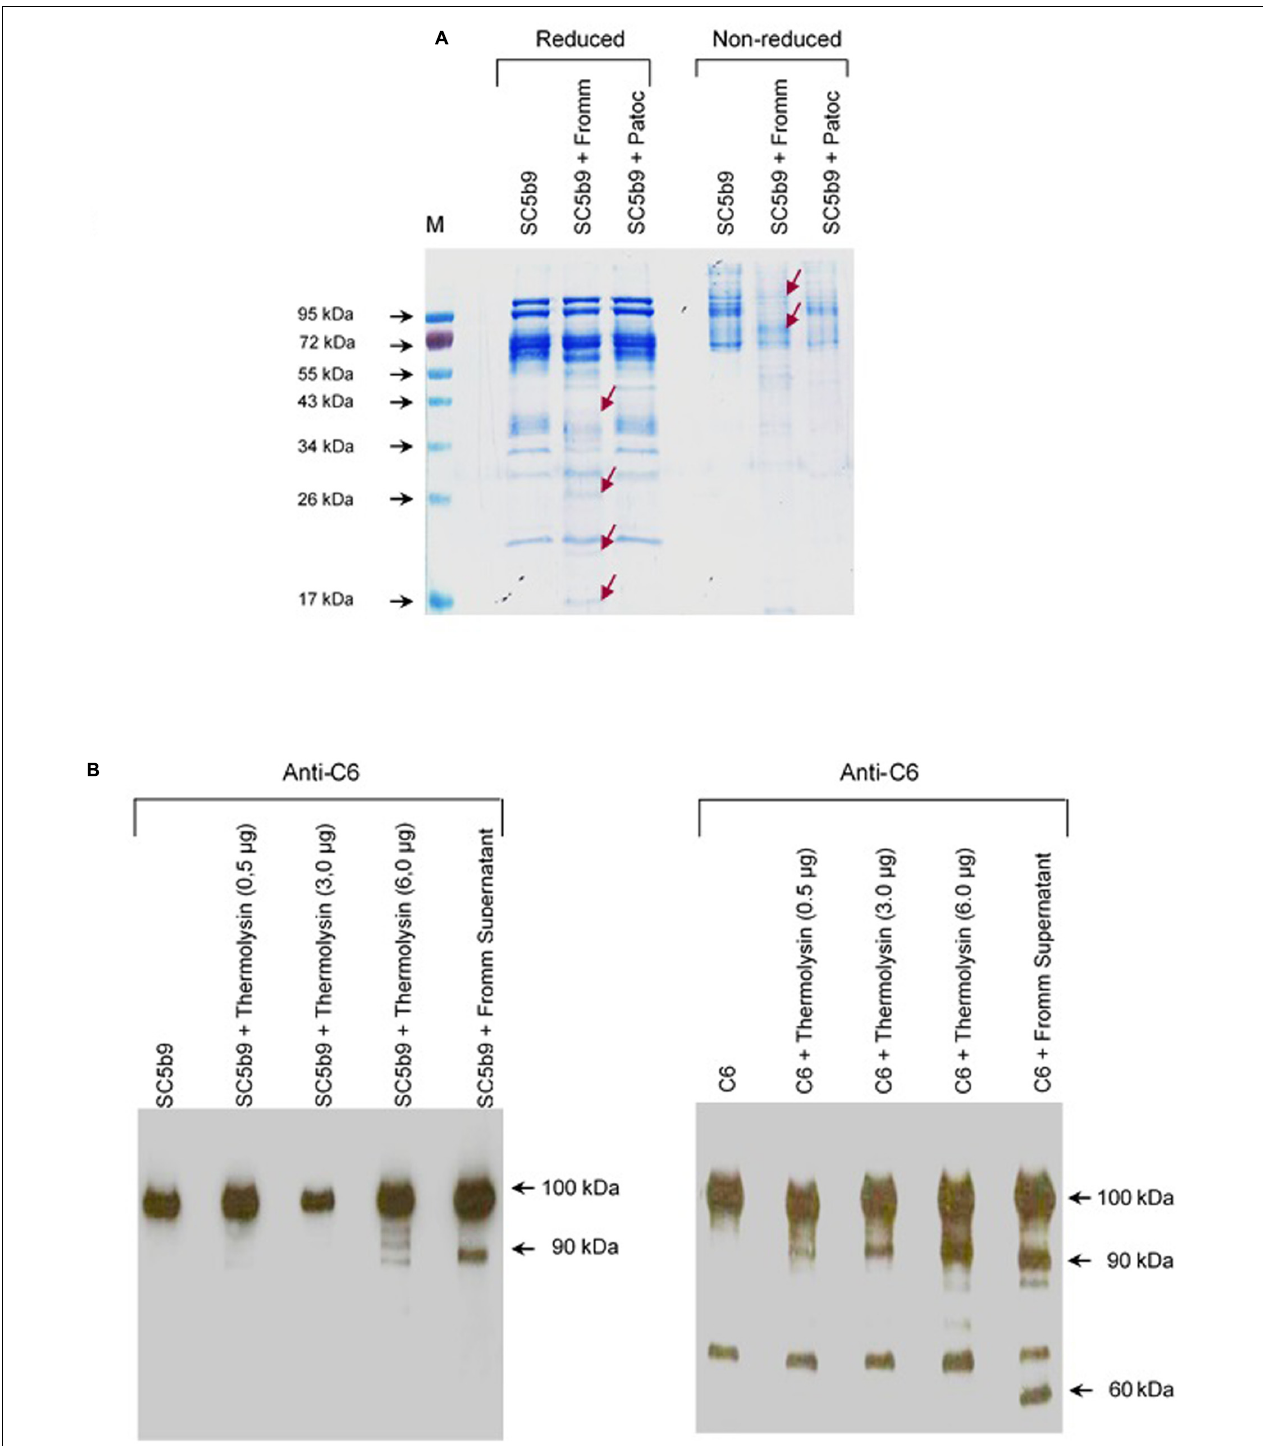
FIGURE 9 | Leptospiral proteases and recombinant Thermolysin target the component C6 from the Membrane Attack Complex. (A) The soluble complex SC5b-9 was incubated with the supernatants of saprophytic L. biflexa serovar Patoc strain Patoc I or pathogenic L. interrogans serovar Kennewiki strain Fromm, for 2 h at 37 ◦ C. The cleavages were analyzed by SDS-PAGE stained with Coomassie blue. (M) Molecular weight marker (Page Ruler, Fermentas). (B) Recombinant Thermolysin had their proteolytic activity tested. The purified component C6 or SC5b-9 were incubated with increasing amounts of Thermolysin (0.5–6 µ g) for 4 h at 37 ◦ C. SPL from L. interrogans serovar Kennewiki strain Fromm was also incubated with SC5b-9 in the same conditions. The cleavages were analyzed by Western blot with anti-human C6 polyclonal antibody.